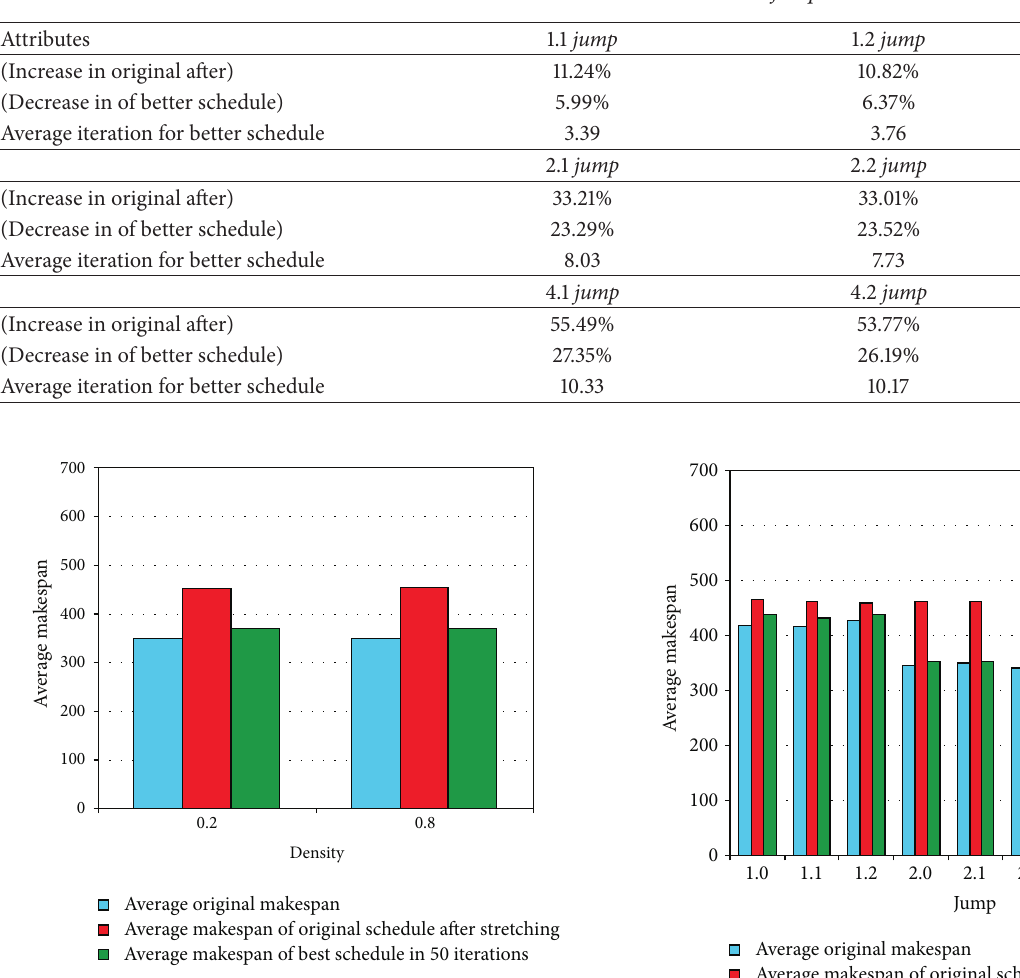
Table 8: Performance for DAGs with different 𝑗𝑢𝑚𝑝 values.